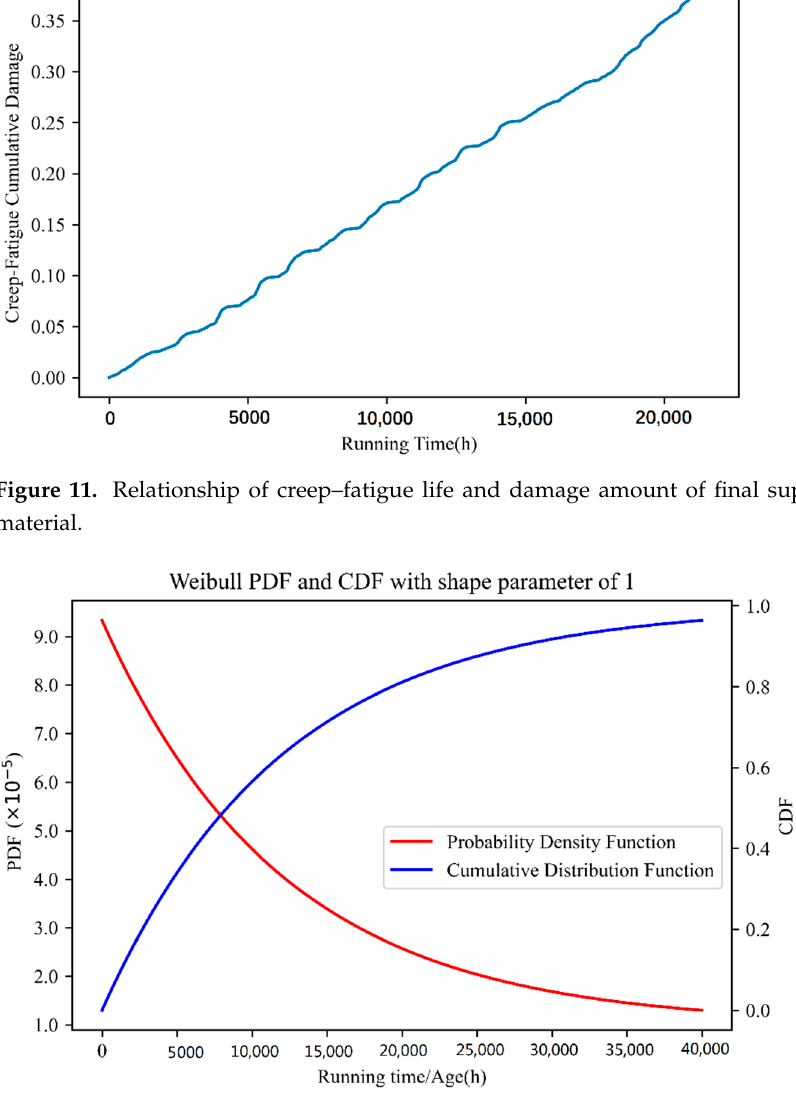
Figure 12. Diagram of the tube Weibull distribution model for the final-stage superheater system .